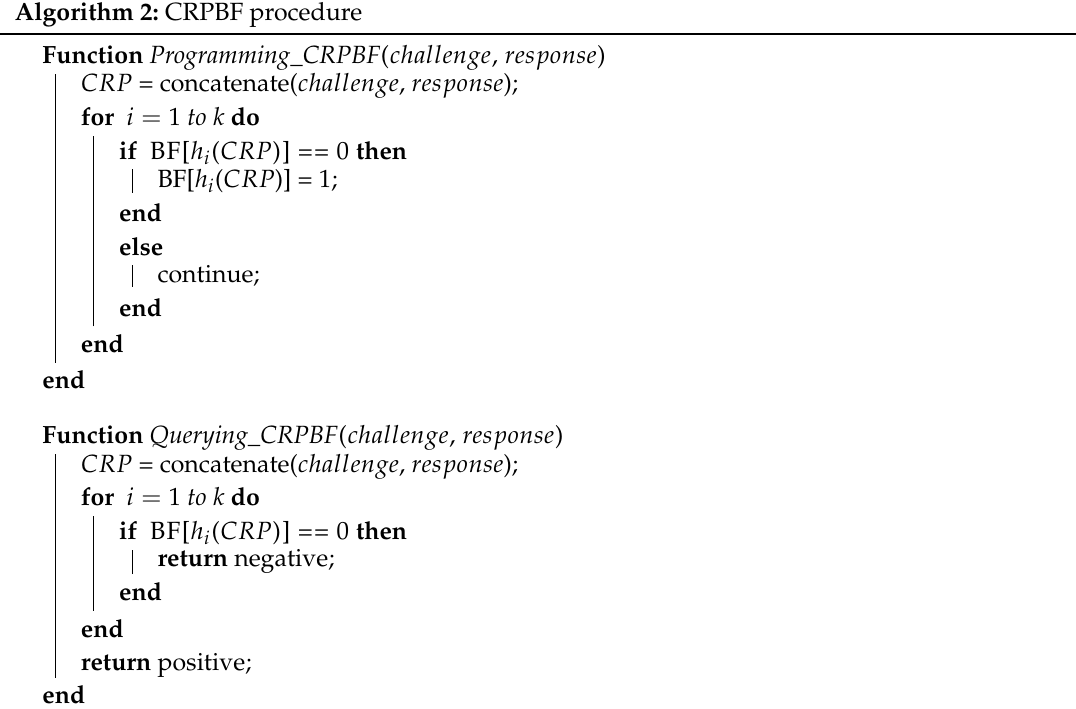
Figure 5. Querying procedure for a